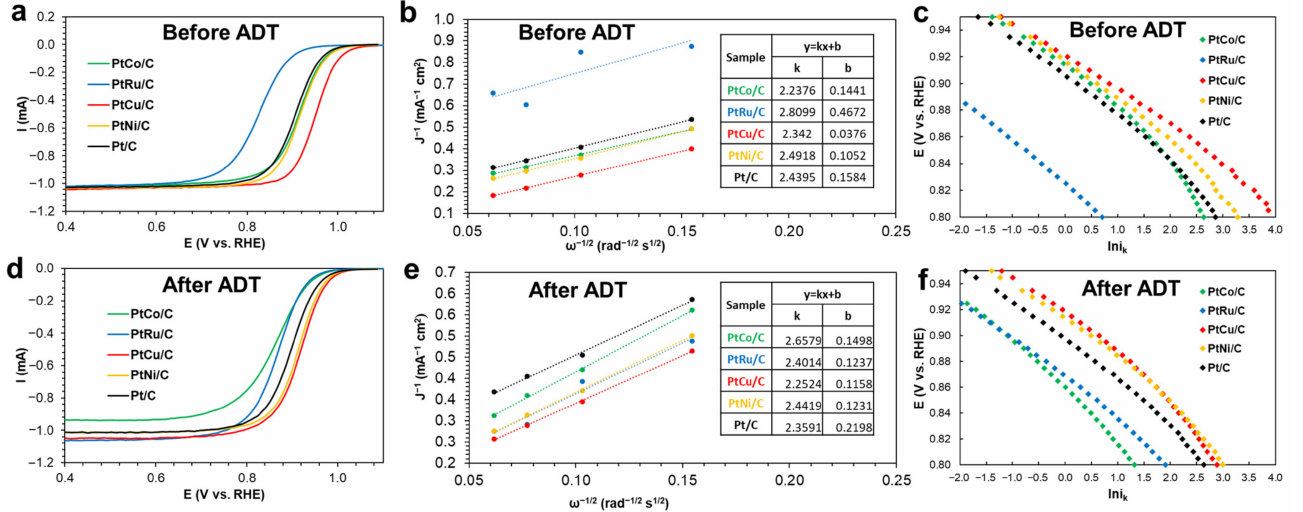
Figure 7. The potentiodynamic polarization curves of the ORR: initial ( a ), after the stress testing ( d ); the dependence of the 1/I k on the RDE rotation speed in the Koutetsky–Levich coordinates where I k is the current on the disk electrode with the area of 0.19625 cm 2 : initial ( b ), after the stress testing ( e ); the Tafel plots: initial ( c ), after the stress testing ( f